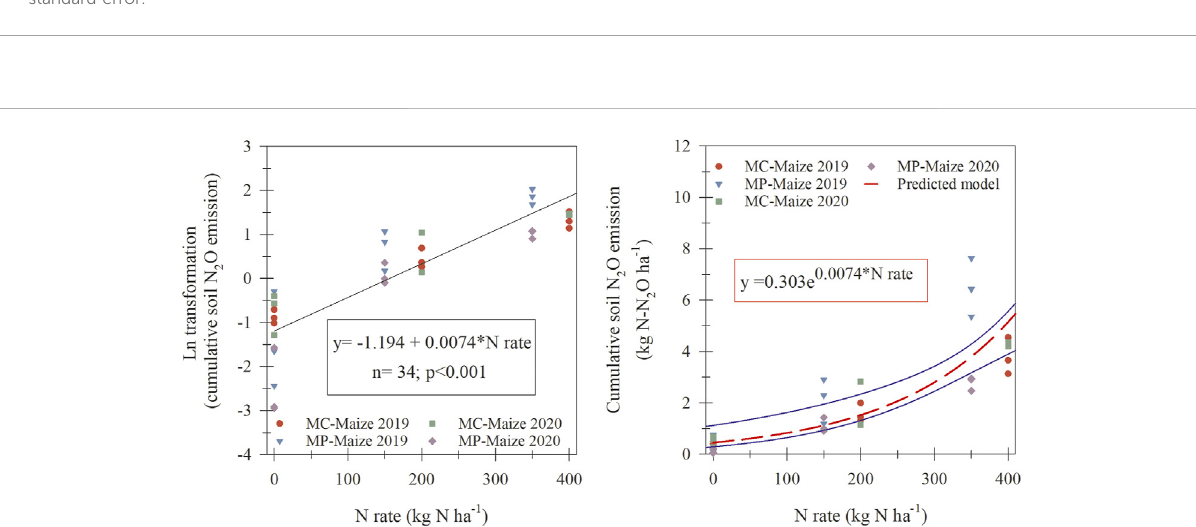
FIGURE 5 RegressionanalysisbetweencumulativesoilN 2 OemissionsandNapplicationrateforbothcropping systems(maize monoculture system, MC; pea-maize cropping system, MP) and both maize growing seasons (maize growing season 2019, Maize 2019; maize growing season 2020, Maize 2020. Black solid lines represent the 95% con fi dence